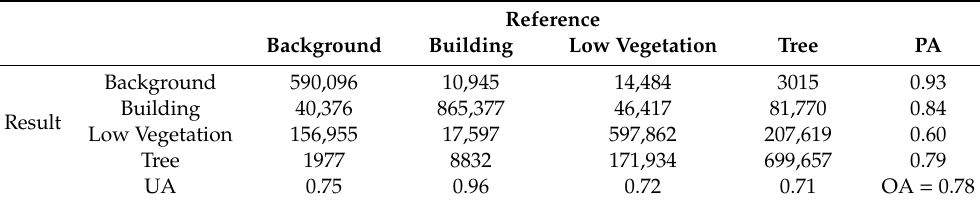
Table 5. Confusion matrix of VBSPM result for Vahingen Dataset.